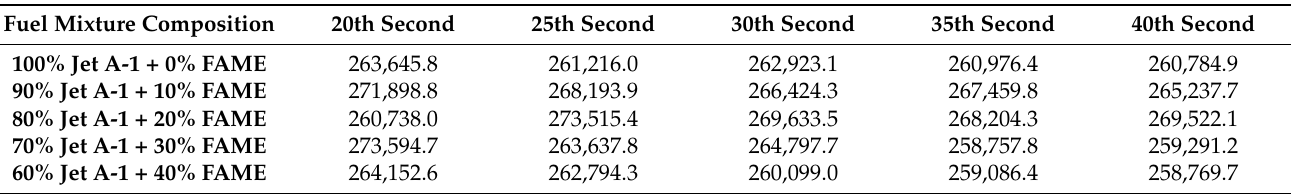
Figure 9. Graphical course of the change in the total air pressure behind the SJE-20 p 2t compressor [Bar] when using different mixtures of Jet A-1 aviation kerosene and FAME biofuel. Table 11. Change in total air pressure behind compressor p2t [Pa] SJE-20 with different concentrations of Jet A-1 aviation kerosene and FAME biofuel.